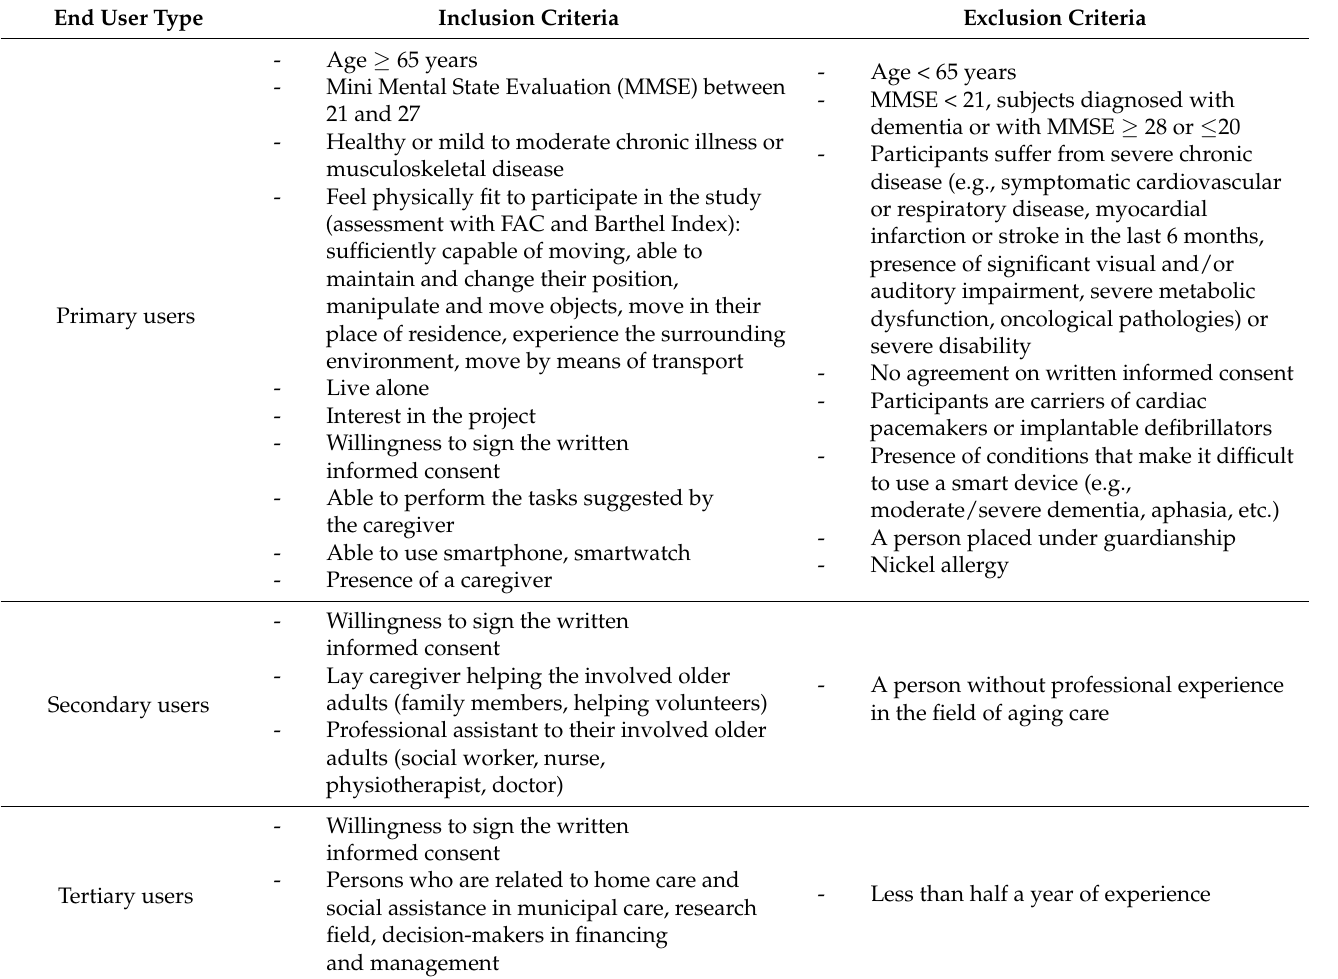
Table 1. Eligibility criteria for primary, secondary, and tertiary